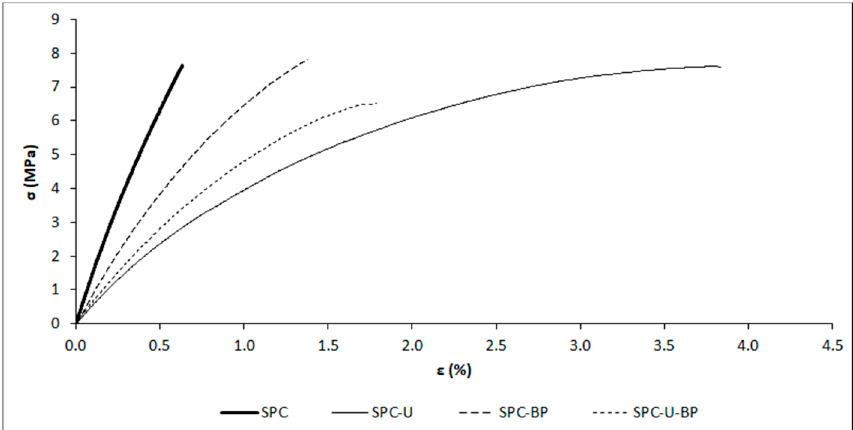
Figure 3. Mean stress-strain curves obtained during the tensile test conducted on the injection- molded pieces.